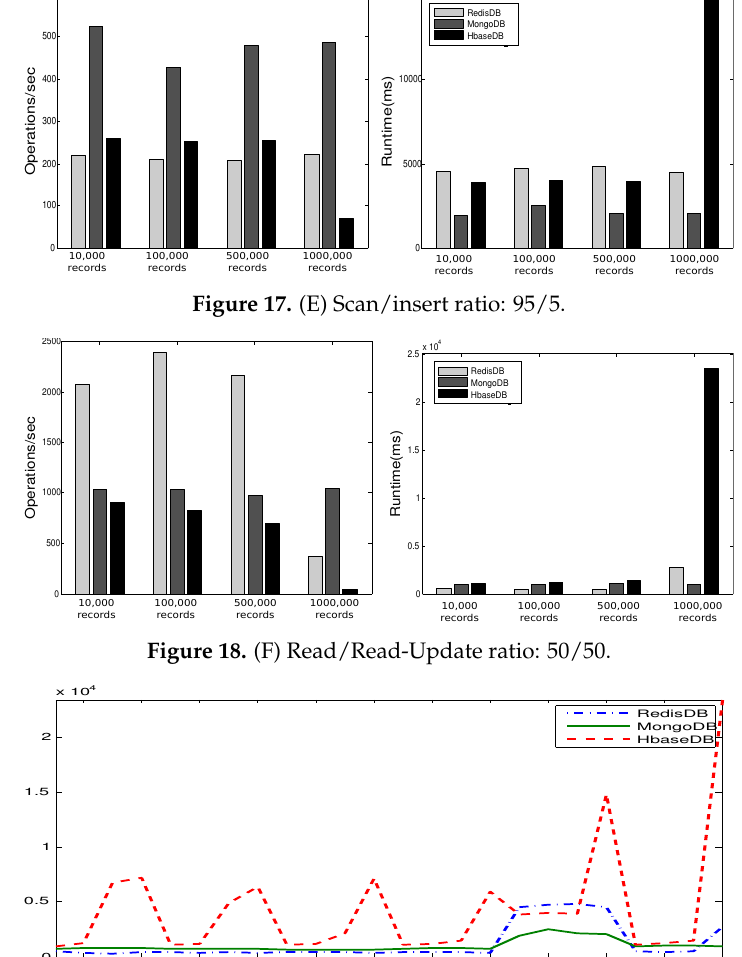
Figure 19. Overall Performance For all